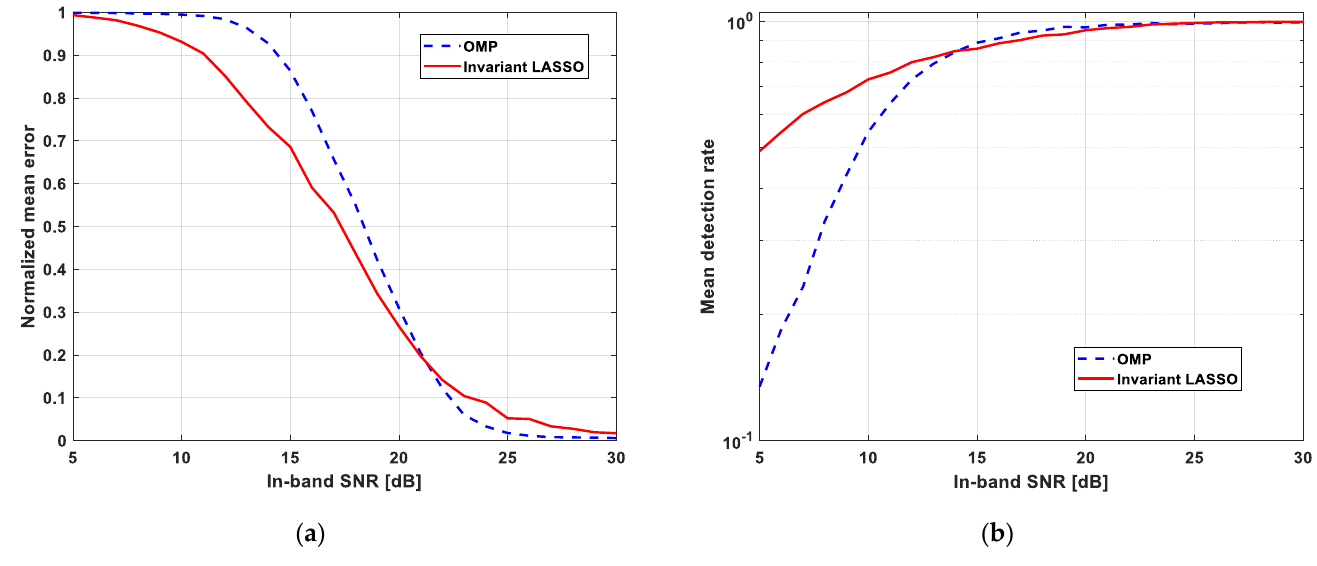
Figure 5. Performance comparison between OMP and LASSO algorithms in terms of: ( a ) Normalized mean error; ( b ) Mean detection rate.